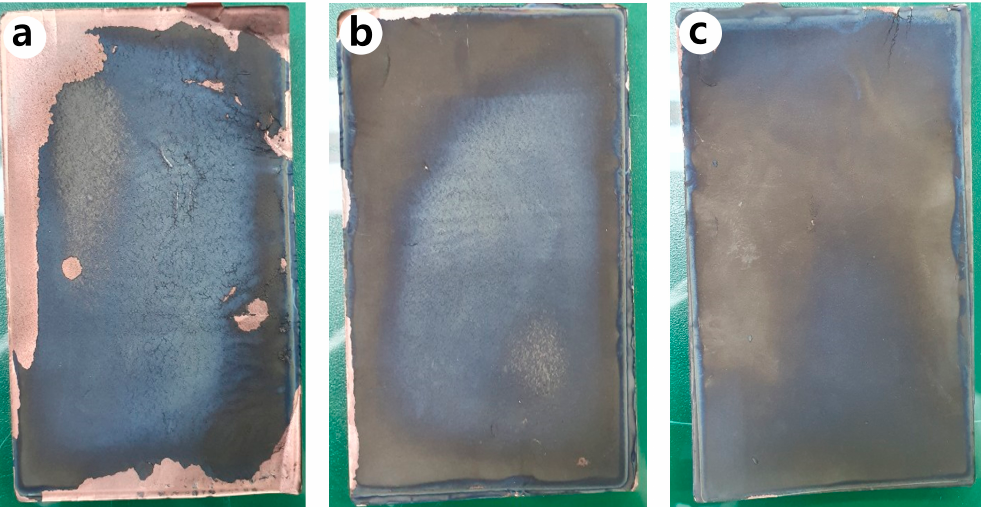
Figure 11. Photographs of the anodes inside the PFC, obtained after 600 cycles: ( a ) N-Si alloy, ( b ) Al 2 O 3 -1, and ( c ) Al 2 O 3 -2 powders.